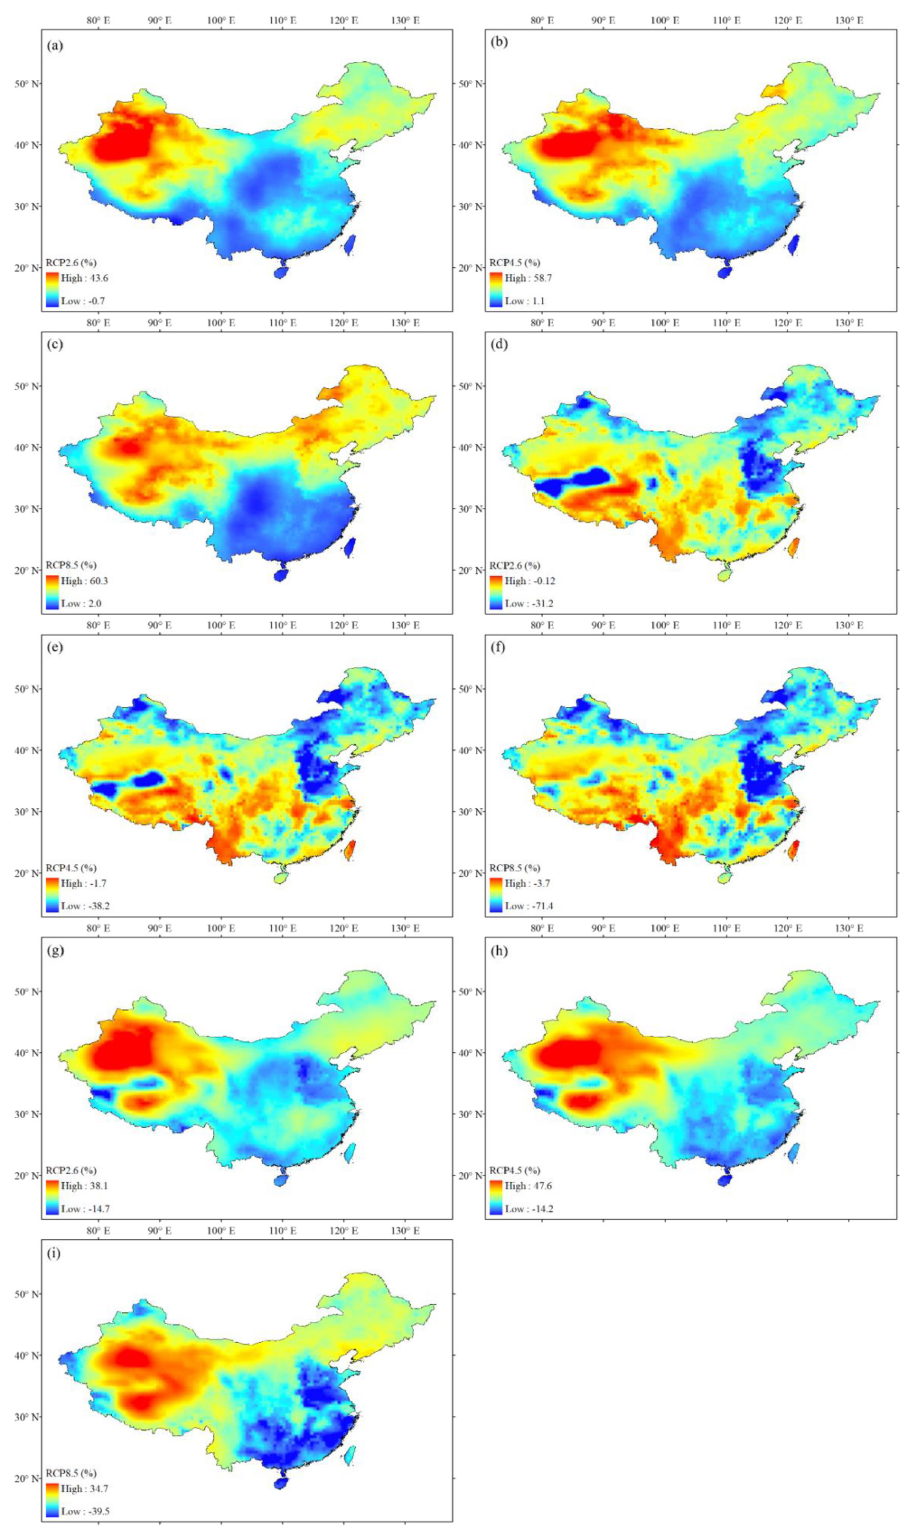
Figure 12. The CMIP5 multi-model ensemble median relative change (%) in the contributions of annual P to R under (a) RCP2.6, (b) RCP4.5, and (c) RCP8.5 scenarios, in the contributions of annual PET to R under (d) RCP2.6, (e) RCP4.5, and (f) RCP8.5 scenar- ios, and in the contributions of climate to R under (g) RCP2.6, (h) RCP4.5, and (i) RCP8.5 scenarios in China for the period 2071–2100 (relative to the baseline